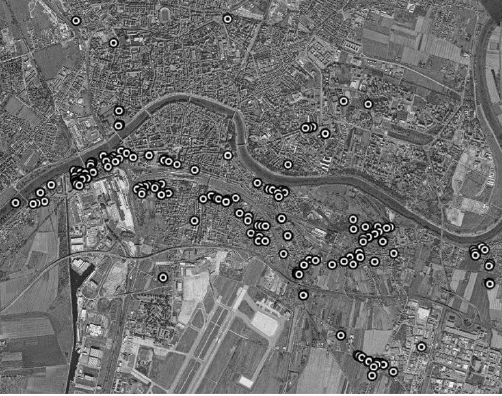
Figure 1. Residential locations of the study sample.